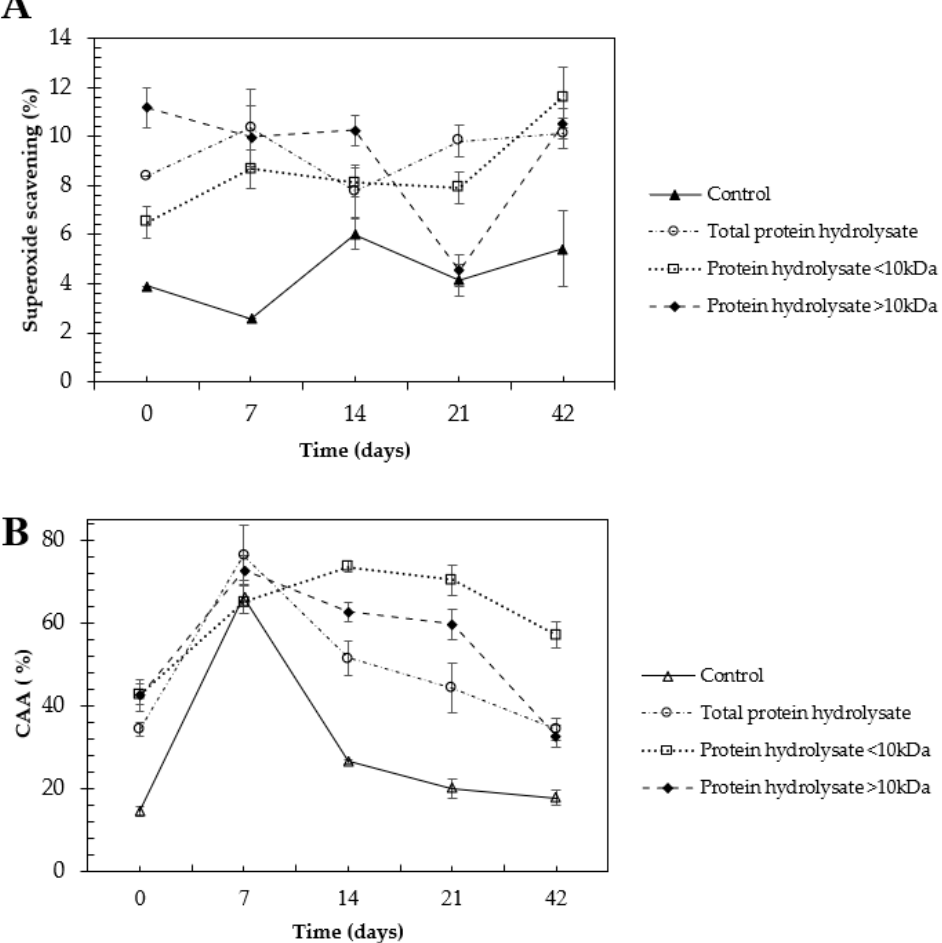
Figure 2. Stability of selenized hydrolysates from chickpea using ( A ) superoxide radical scavenging activity throughout 28 days of storage at − 20 °C and ( B ) cellular antioxidant activity (CAA) at 25 µg/mL throughout 42 days of storage at − 20 °C. Total selenized hydrolysate, selenized hydrolysate fraction >10 kDa, selenized hydrolysate fraction <10 kDa, and total control hydrolysate. Graphs show the means ± standard deviation of a sample of three replicates. The significantly different means are labeled with an asterisk each time the test is evaluated by Fisher´s post hoc test with 95% confidence compared to all days.